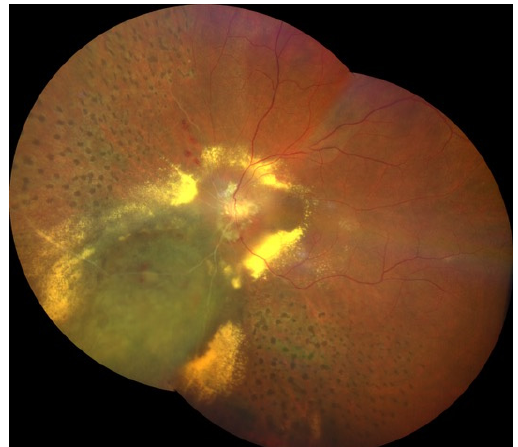
Figure 1. Color fundus photography showing a laser-treated radiation chorioretinopathy, characterized by chorioretinal atrophy, ischemia, ghost vessels, cotton wool spots, hard exudates and retinal hemorrhages; hemorrhages and hard exudates involve both the macular region (radiation maculopathy) and the optic nerve (radiation optic neuropathy).